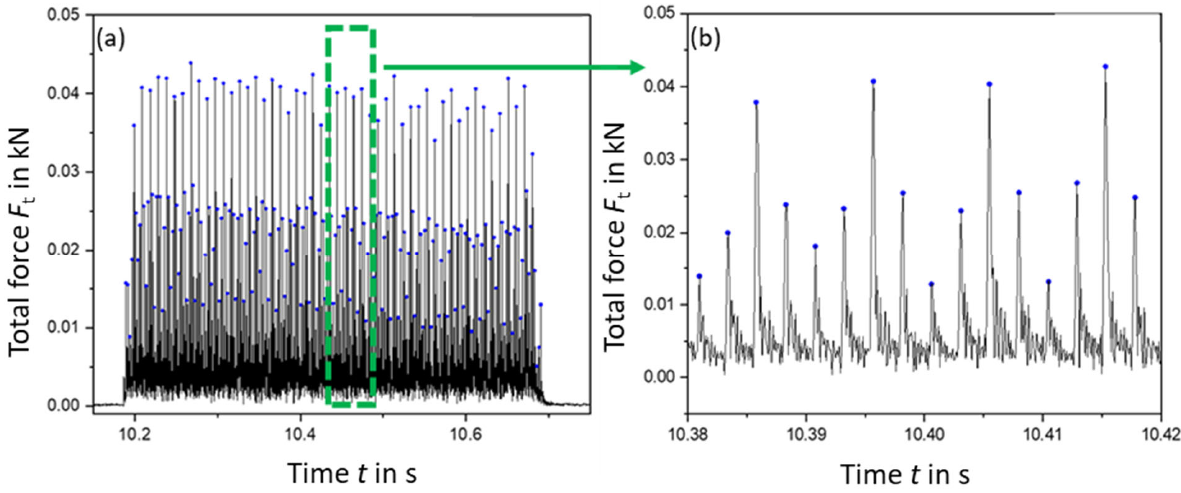
Figure 3. Peak identification in calculated total force, after smoothing and offset correction in one milling line ( a ) and close-up showing four tool rotations ( b ).